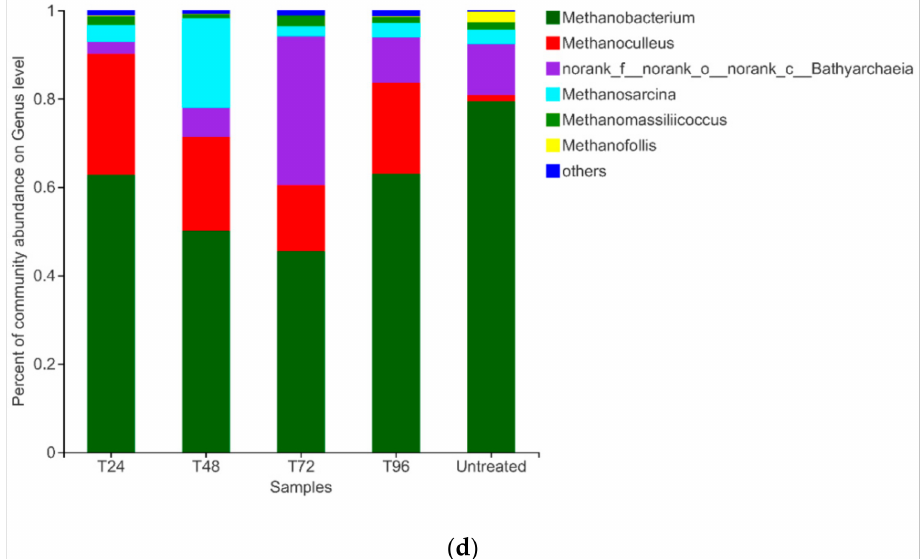
Figure 7. Community composition analyses: ( a ) bacterial distributions at Phylum level; ( b ) bacterial distributions at Genus level; ( c ) archaeal distributions at Phylum level; ( d ) archaeal distributions at Genus